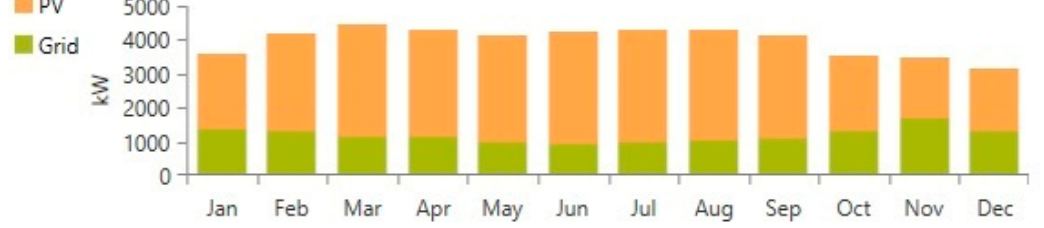
Figure 5. Monthly average electrical generation by solar PVs and grid .